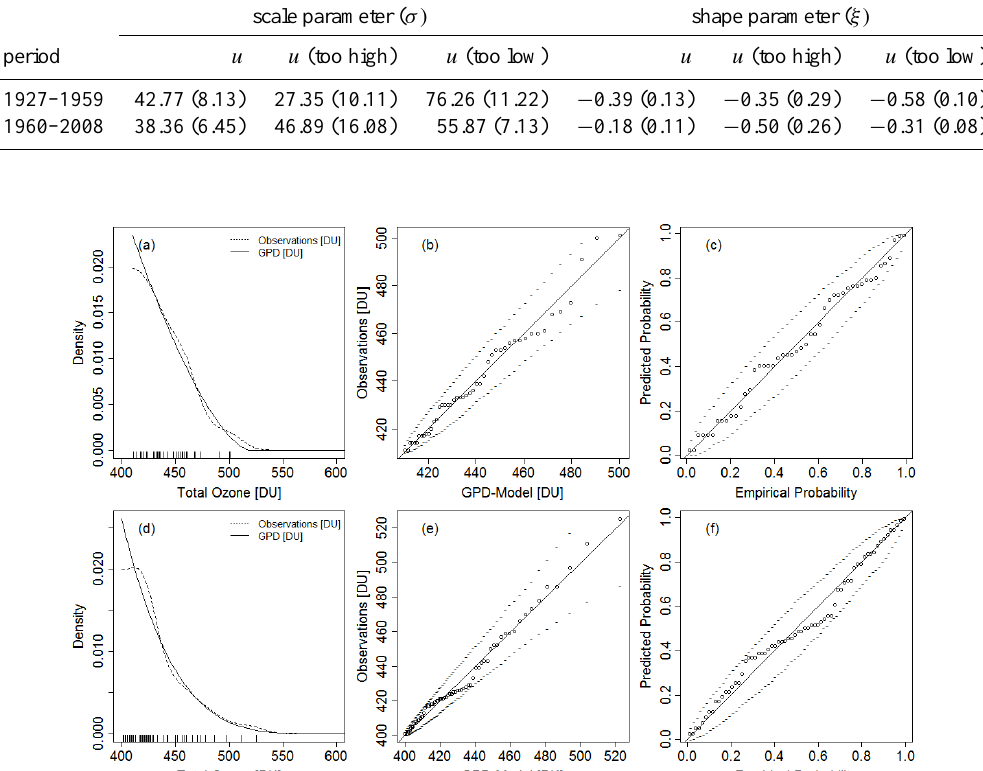
Fig. 5. (a) Tail density plot of observations and GPD for high total ozone ( u = 410DU), (b) Quantile-Quantile-comparison between observed and GPD-model predicted extreme values, (c) empirical and predicted probability for these events (all three for the month of March in 1927– 1959). (d–f) same as (a–c) but for period 1960–2008 with u = 400DU. In (b–c) and (e–f) dotted lines represent the 95% confidence intervals, straight lines give the identity